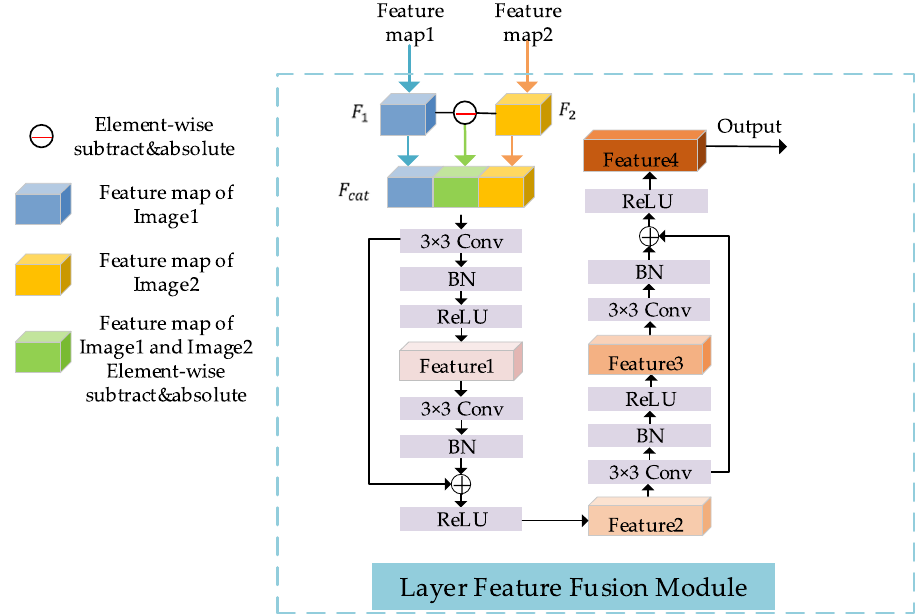
Figure 2. The structure of LFFM (created by ‘Microsoft Office Visio 2013’ url: https:// www. micro soft. com/ zh- cn/ micro soft- 365/ previ ous- versi ons/ micro soft- visio-